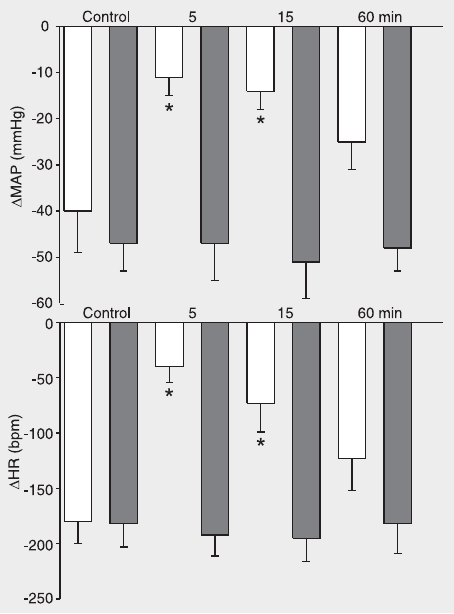
Figure 3. Changes in mean arterial pressure ( ∆ MAP, top) and heart rate ( ∆ HR, bottom) in response to sero- tonin injection (5-HT, 2 µg/rat, iv ) before (control re- sponse) and 5, 15, and 60 min after bilateral injections of muscimol (50 pmol/50 nl, N = 8; open bars) or baclofen (12.5 pmol/50 nl, N = 7; filled bars) into the NTS. *P < 0.05 compared to the respective control (ANOVA followed by the Tukey test).